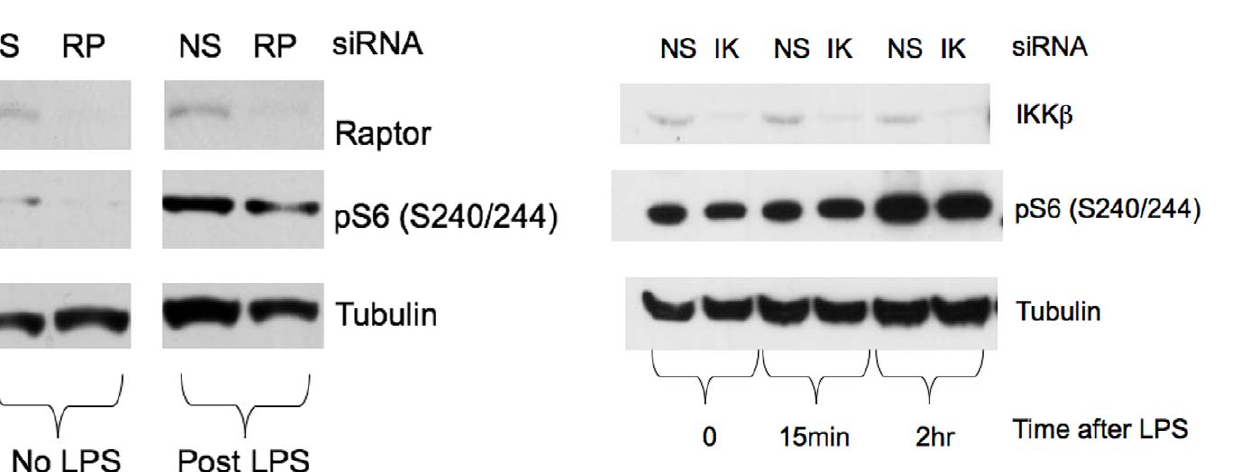
Figure 8. IKK b was not required for LPS-induced mTORC1-S6K activation. IKK b was suppressed in RAW cells by siRNA (IK) 48 hr prior to LPS stimulation. Nonsense siRNA constructs (NS) served as controls. Representative immunoblots show that IKK b suppression had no effect on mTORC1-S6K activation in LPS-treated RAW cells as reflected by pS6 levels.